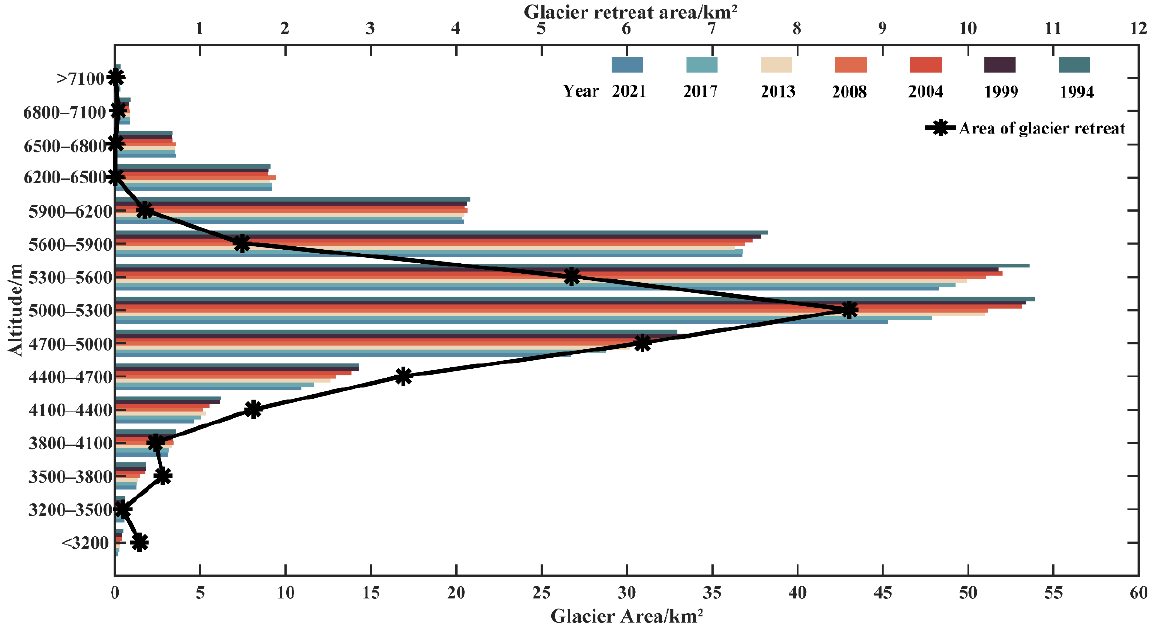
Figure 5. The area of glacier distribution at different altitudes each year.